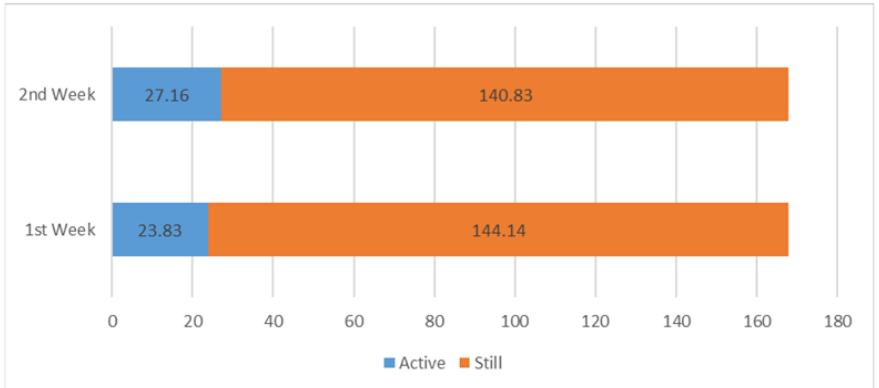
Figure 16. Time spent active or still during two weeks.